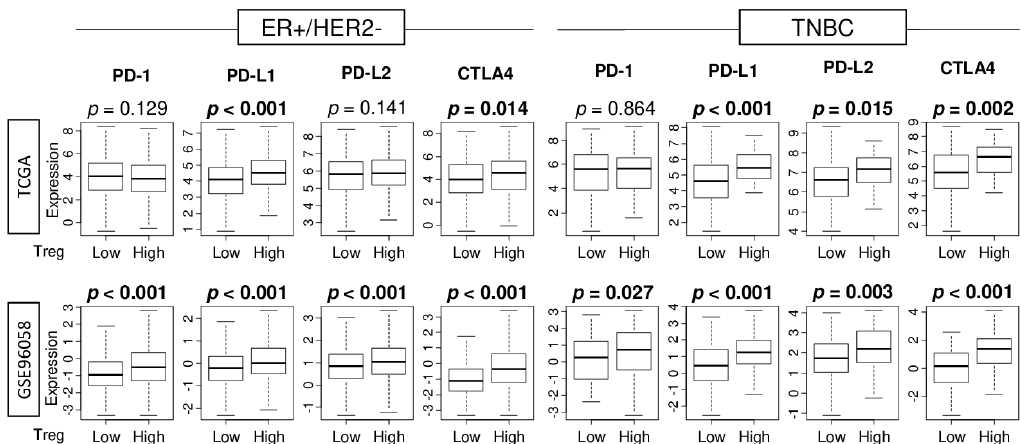
Figure 5. Association of Treg infiltration with expression of immune checkpoint molecules. Boxplots comparing low and high infiltration of Tregs in gene expression of immune checkpoint molecules in ER-positive / HER2-negative and TNBC patients in the TCGA and GSE96058 cohorts which have the PD-L1 ( CD274 ) expression data. Mann-Whitney U test was used for the analysis.